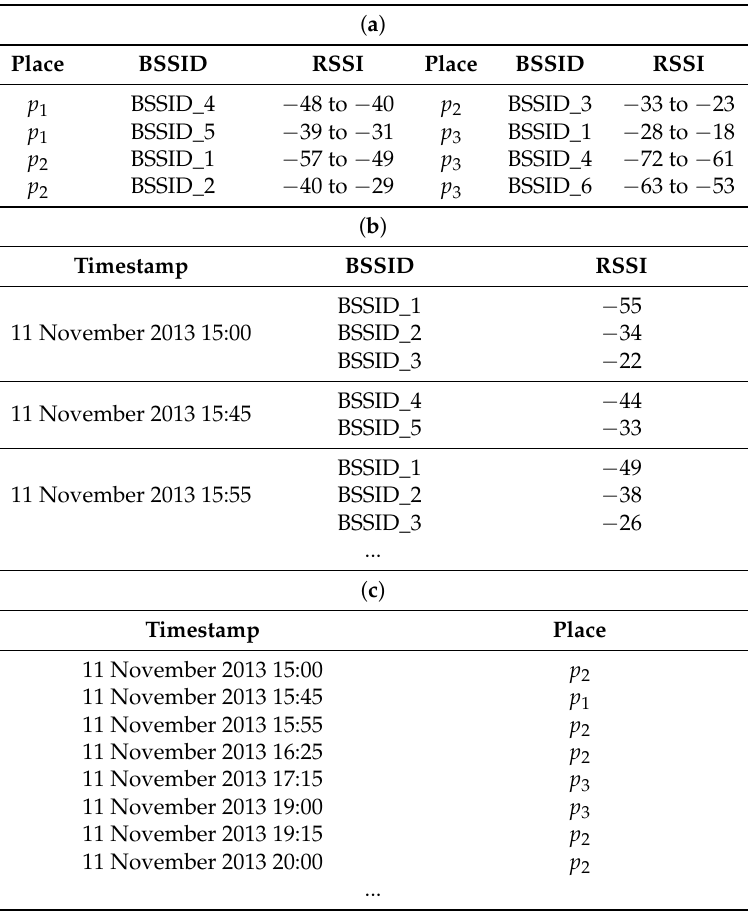
Table 1. Examples of: ( a ) the WiFi fingerprinting database; ( b ) raw WiFi data; and ( c ) places